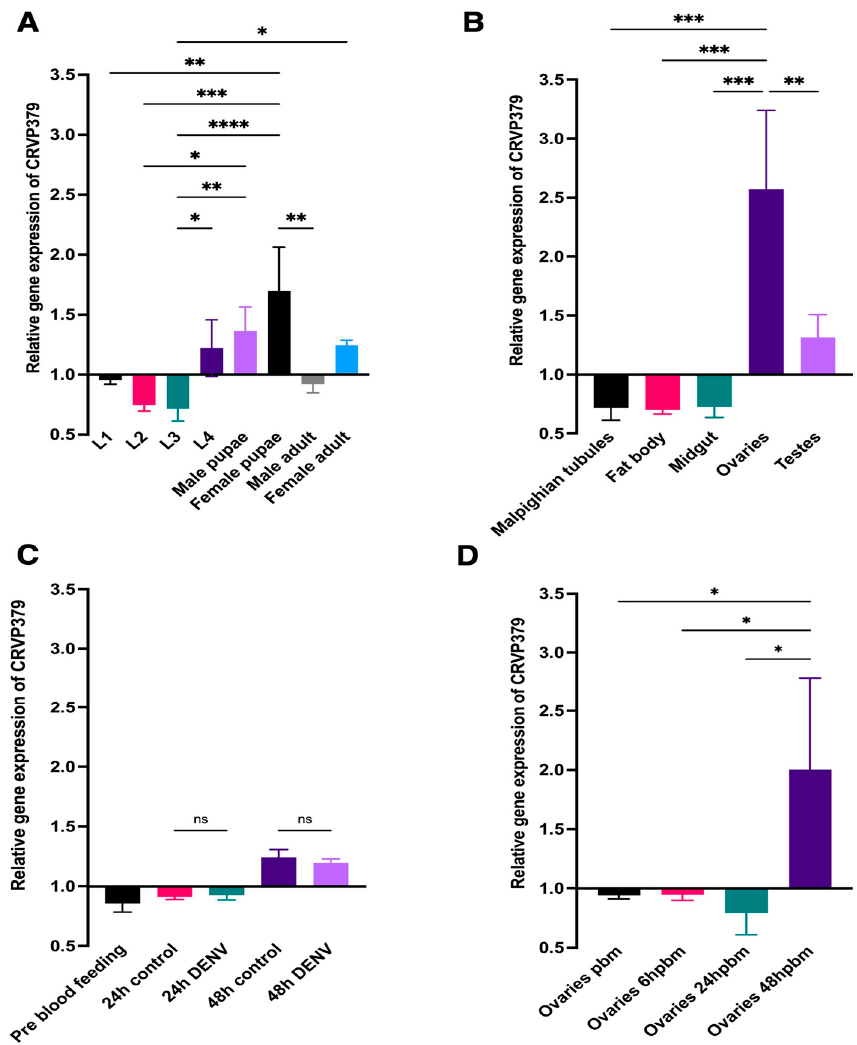
Figure 1. Relative gene expression of CRVP379 in different life stages and tissues of Aedes aegypti . ( A ) CRVP379 relative gene expression in the whole bodies of larval (L1–L4) and both male and female pupal and adult stages. ( B ) CRVP379 relative gene expression in various tissues of adult mosquitoes. ( C ) CRVP379 relative gene expression in the midgut before blood feeding and at 24 and 48 h after DENV infection. ( D ) CRVP379 relative gene expression in the ovaries before blood feeding and at 24 and 48 h after blood feeding. Means were compared with Tukey’s multiple comparisons test; * = p < 0.05, ** = p < 0.01, *** = p < 0.005, **** = p < 0.0001. Relative gene expression (RGE) was